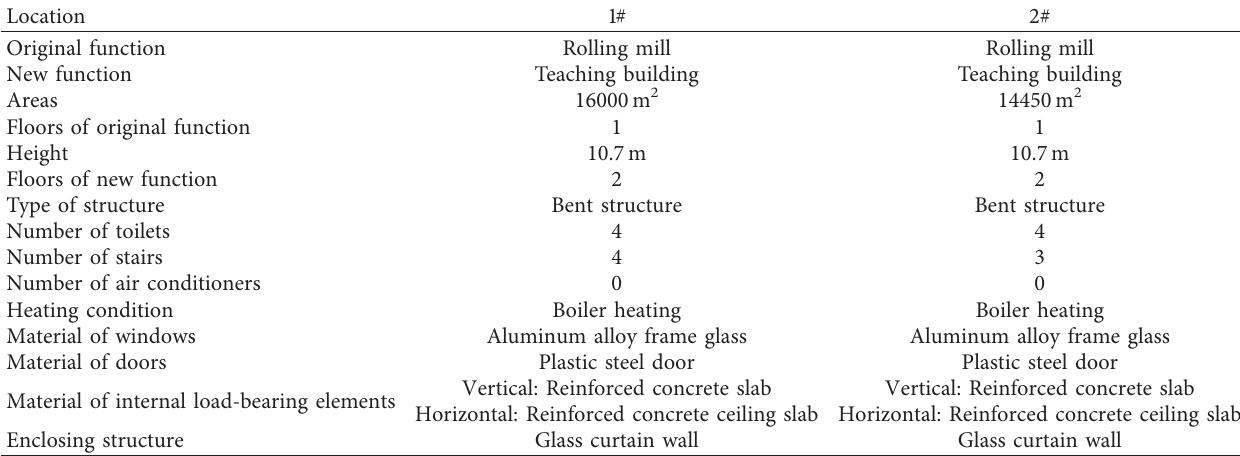
Table 1: Specifications of the